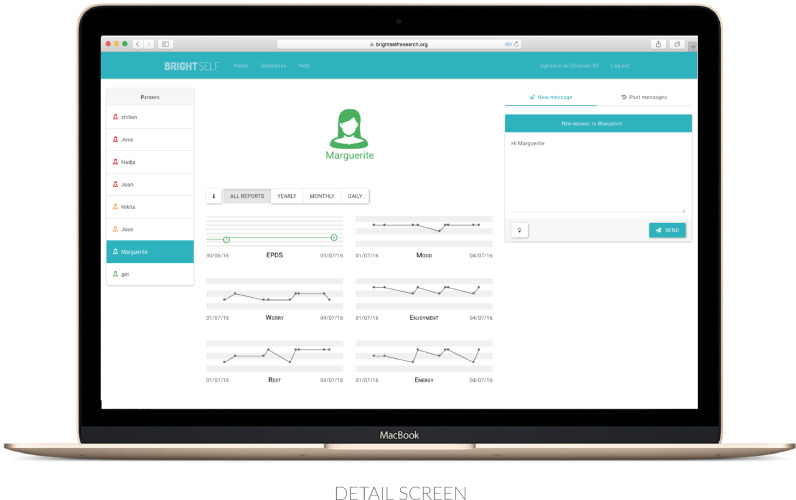
The detail screen.